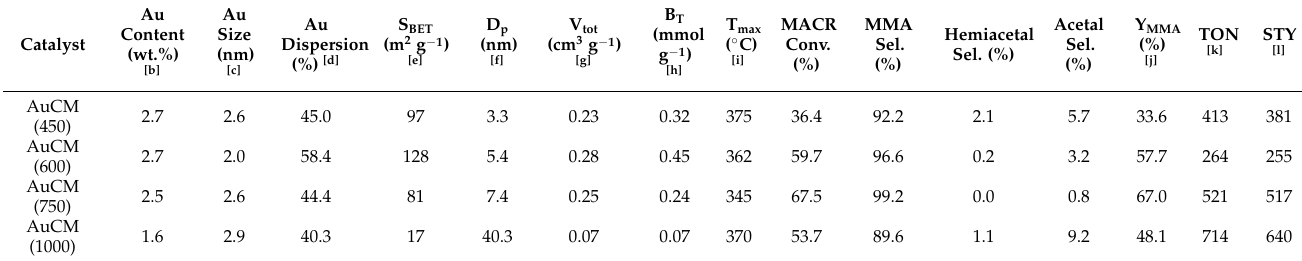
Table 2. Physicochemical properties of AuCM catalysts with different calcination temperatures of 450, 600, 750, and 1000 °C and their catalytic reaction summaries showing the MACR conversion and product selectivity [a] .